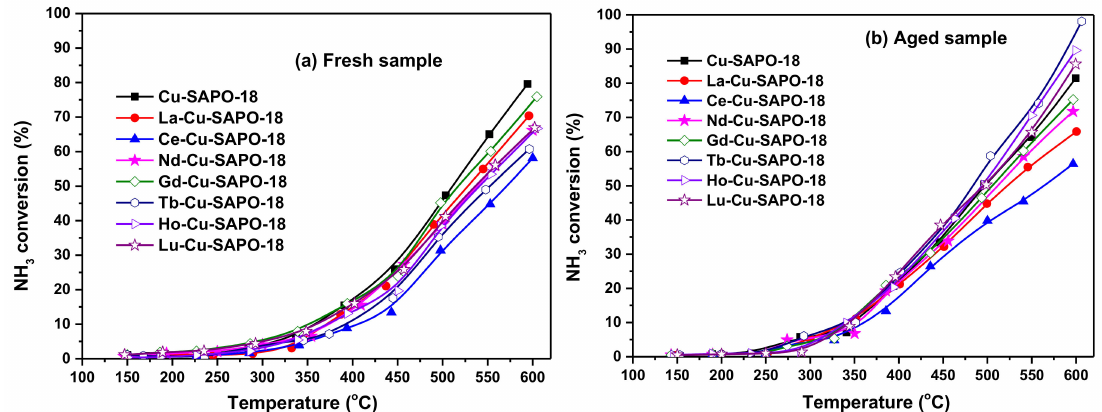
Figure 4. Catalytic activities for NH 3 oxidation over the ( a ) fresh and ( b ) hydrothermally aged Cu-SAPO-18 and M-Cu-SAPO-18 samples at a GHVS of 130,000 h − 1 . The reactant feed composition: 500 ppm NH 3 , 14 vol % O 2 , and N 2